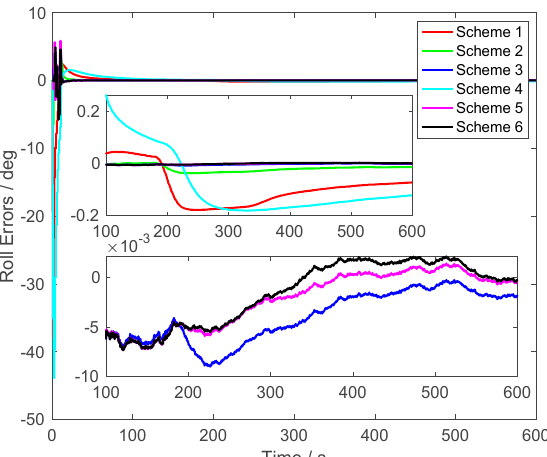
Figure 3. The pitch errors.